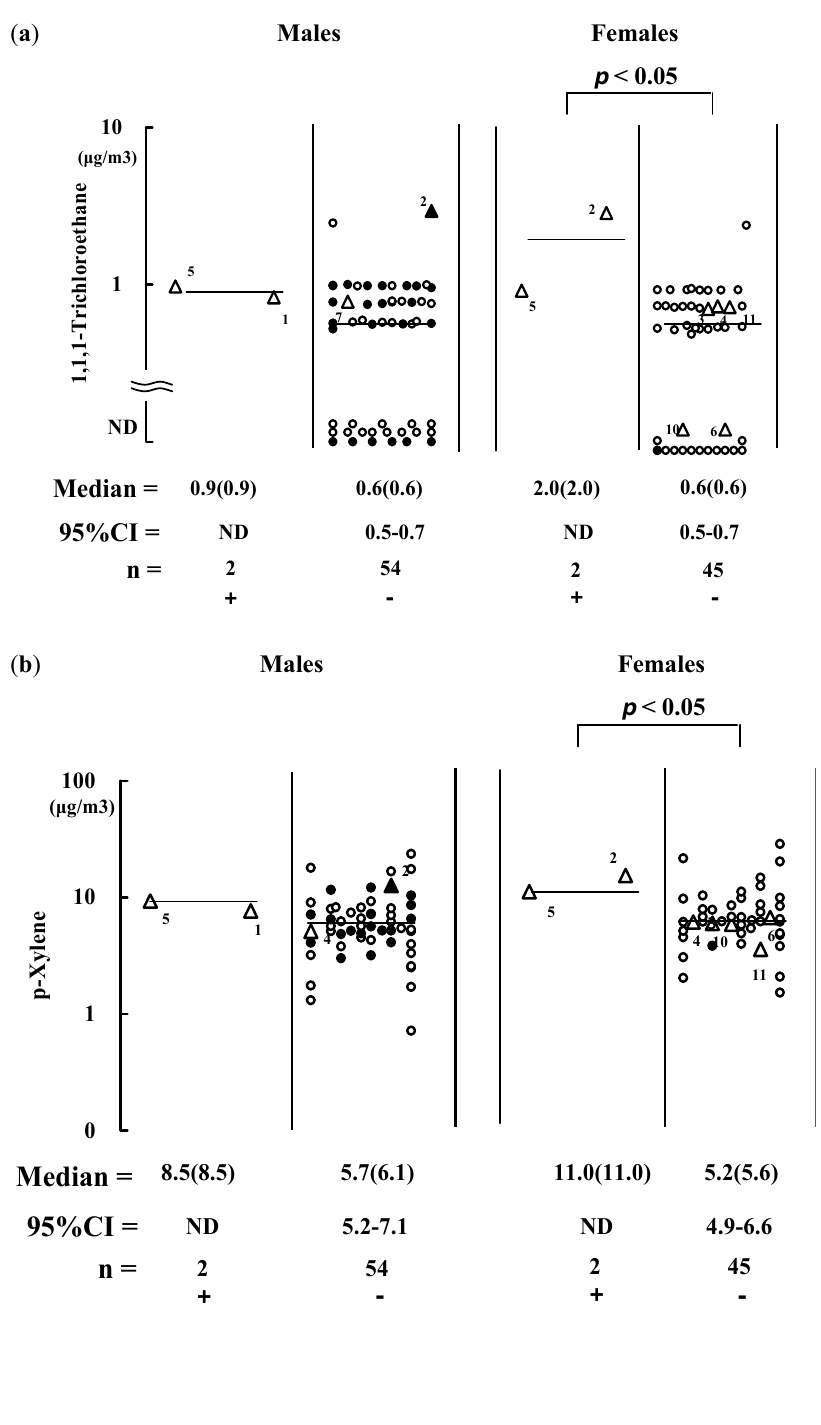
Figure 2. Air concentrations of 1,1,1-trichloro-ethane ( a ) and p-xylene ( b ) in bedrooms. These values were compared between residents with (+) and without ( − ) symptoms during the sampling. Symbols are specified in Figure 1. Bar = median value. Point estimation of median is in parenthesis; 95% CI = 95% confidence interval. ND = not determined because of the small number of